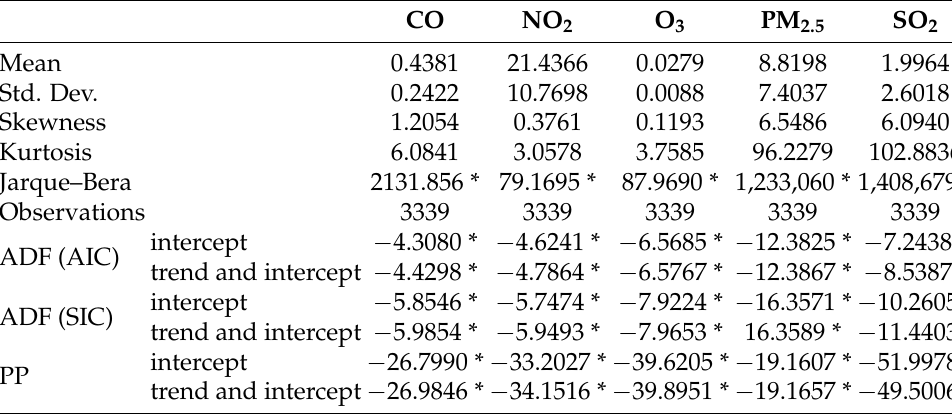
Table A1. Descriptive statistics: seasonally adjusted